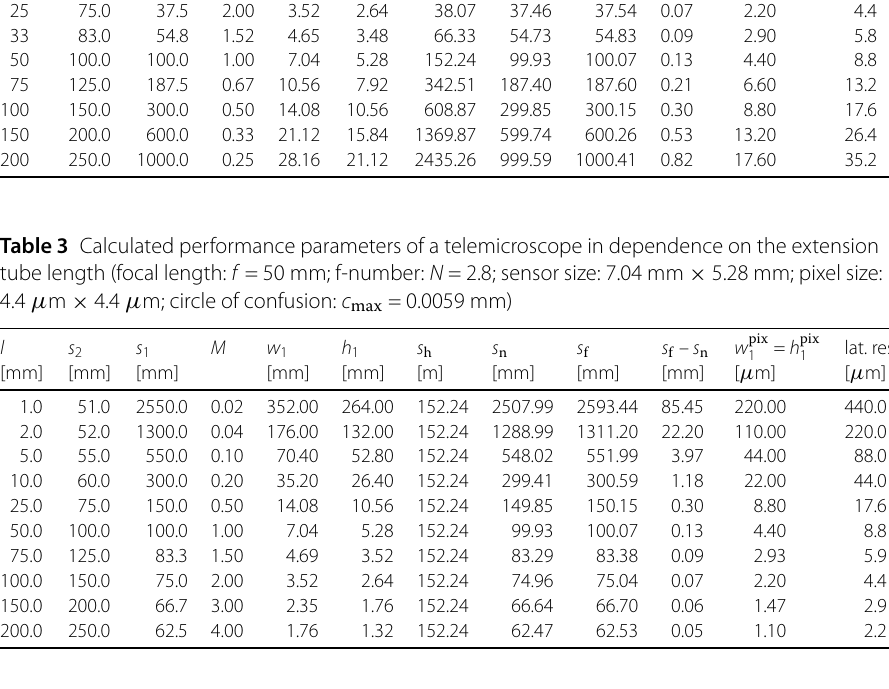
Table 4 Calculated performance parameters of a telemicroscope in dependence on the f-number (focal length: f = 50 mm; extension tube length: l = 50 mm; sensor size: 7.04 mm × 5.28 mm; pixel size: 4.4 μ m × 4.4 μ m; circle of confusion: c max = 0.0059